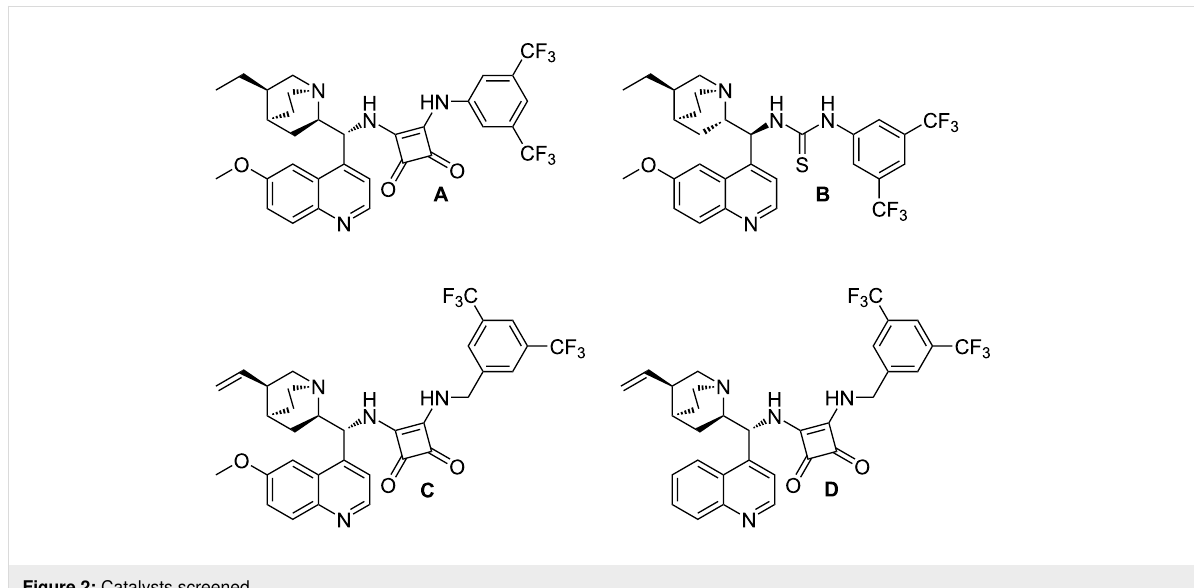
Figure 2: Catalysts screened.